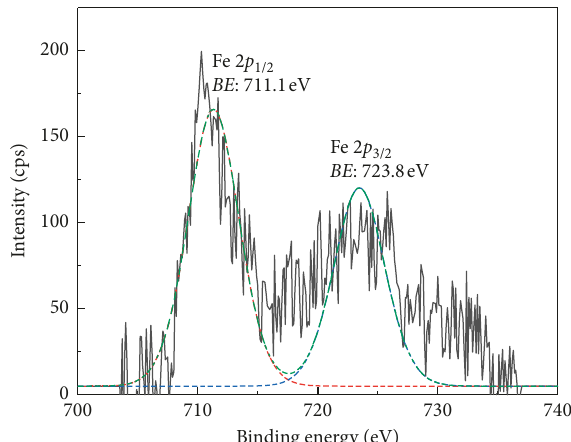
Figure 4: XPS spectrum of the Fe 2p peak of 1.0 at% of Fe-doped TiO